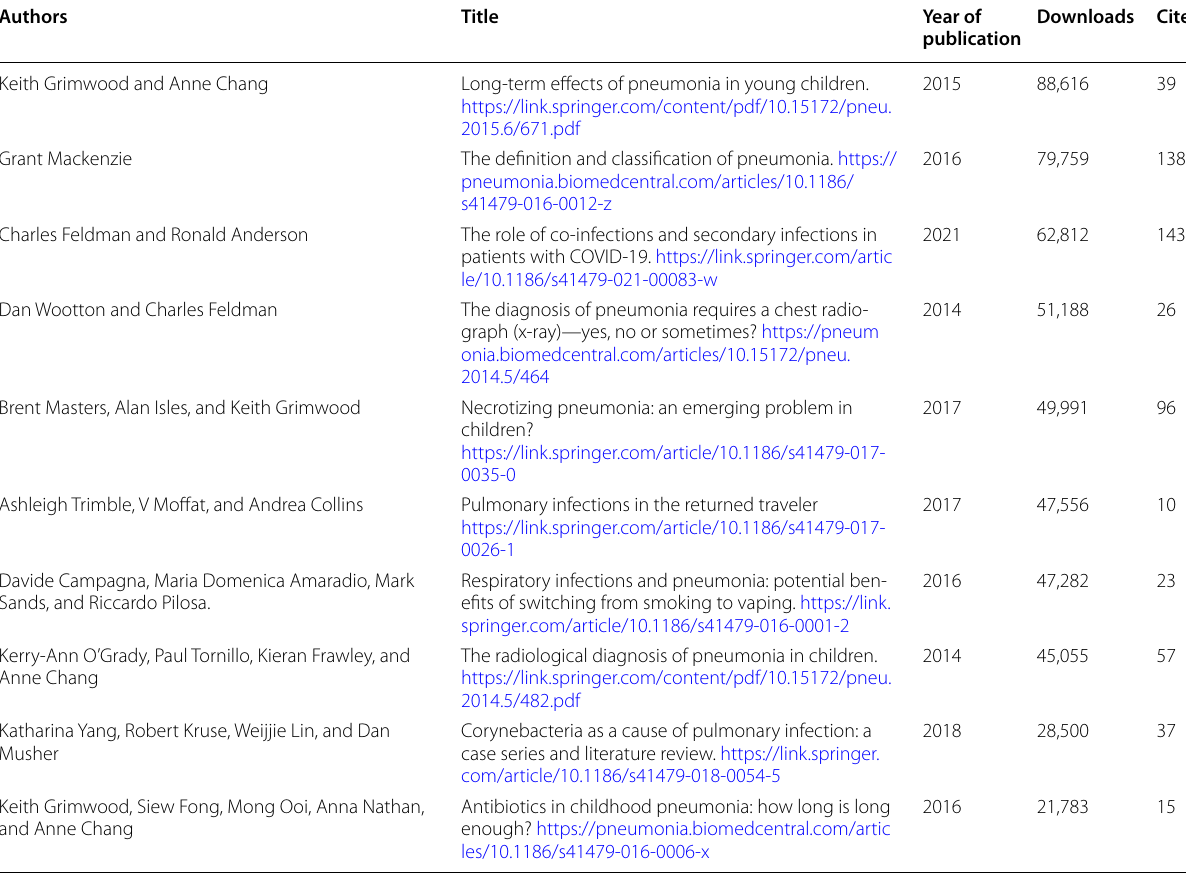
Table 1 Top 10 most downloaded manuscripts in Pneumonia in